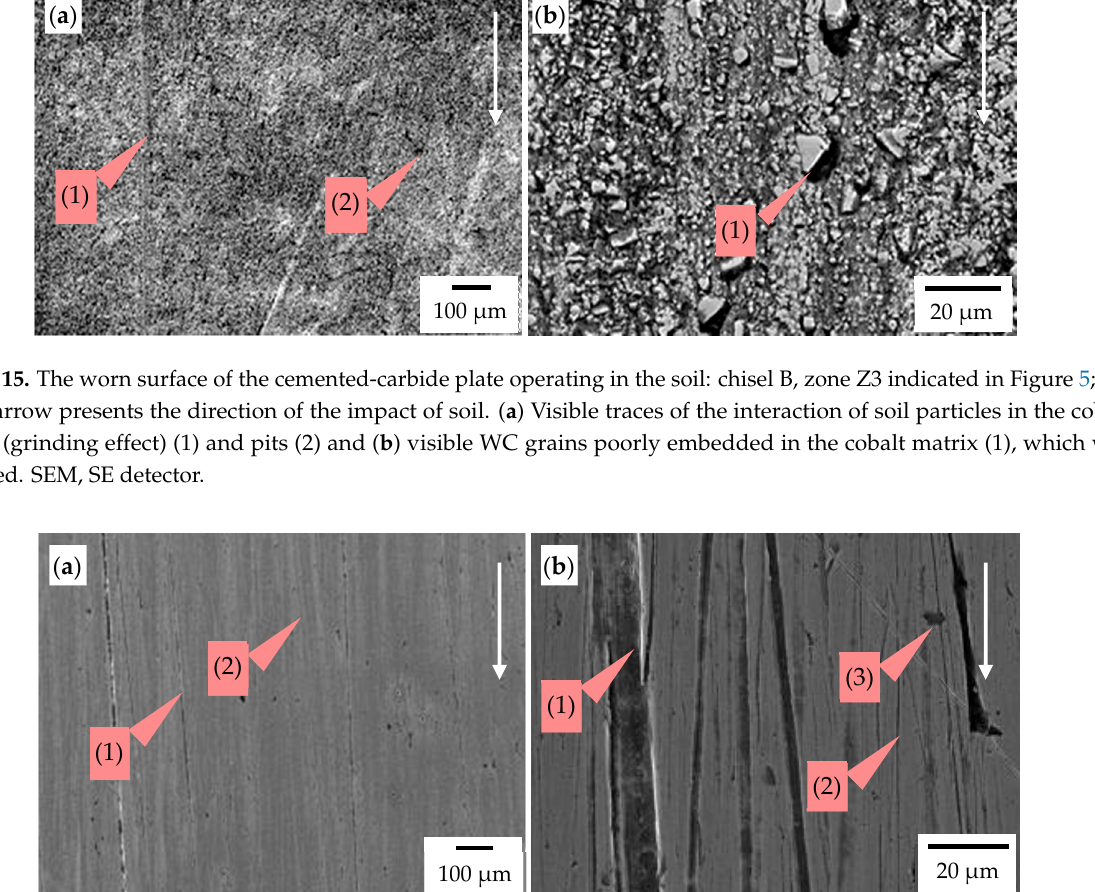
Figure 14 . The worn surface of the cemented-carbide plate operating in the soil: chisel A, zone Z2 indicated in Figure 5; the white arrow presents the direction of the impact of soil particles. ( a ) Visi- ble pits (1) caused by chipping out of WC grains from the cobalt matrix and ( b ) visible crushed WC grains (1) and pits (2). SEM, SE detector.